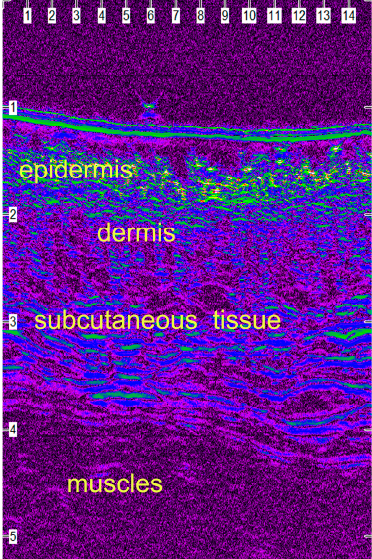
Figure 10. Ultrasonographic images of the normal canine skin of the lateral thigh. The epidermis, dermis and subcutaneous tissue are clearly visible. The digitized scans are visualized using a color palette (rainbow) and are compressed laterally to facilitate viewing of the wound area (scale is in mm).